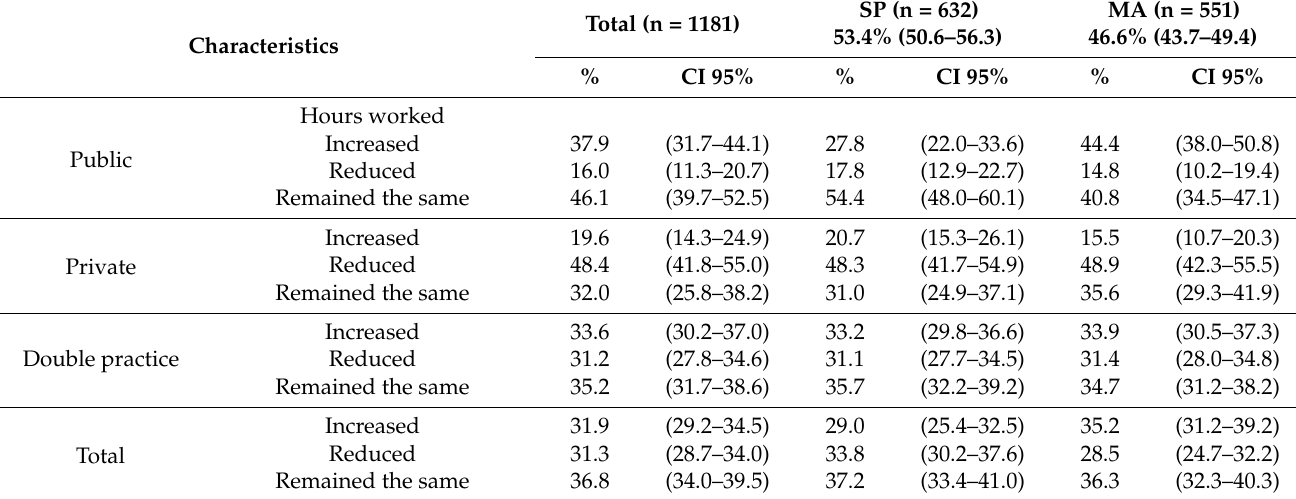
Table 3. Perceptions of the impacts of the COVID-19 pandemic on hours worked among physicians interviewed in SP and MA, Brazil,